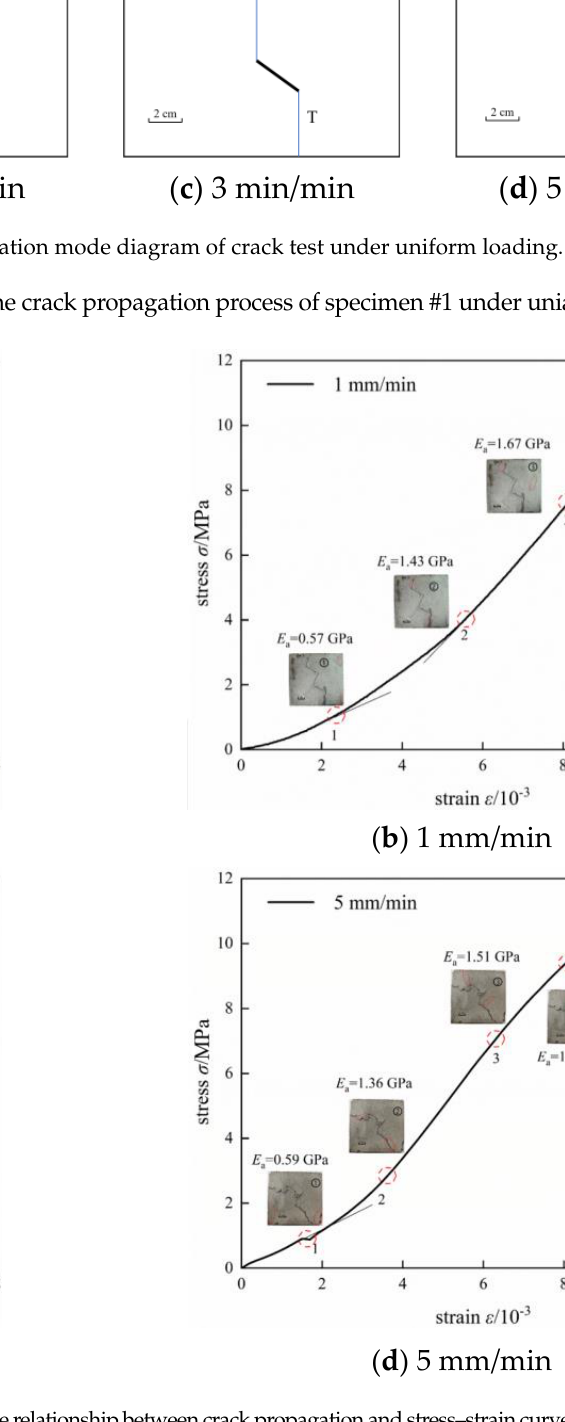
Figure 6. Correspondence relationship between crack propagation and stress – strain curve of typical specimen.